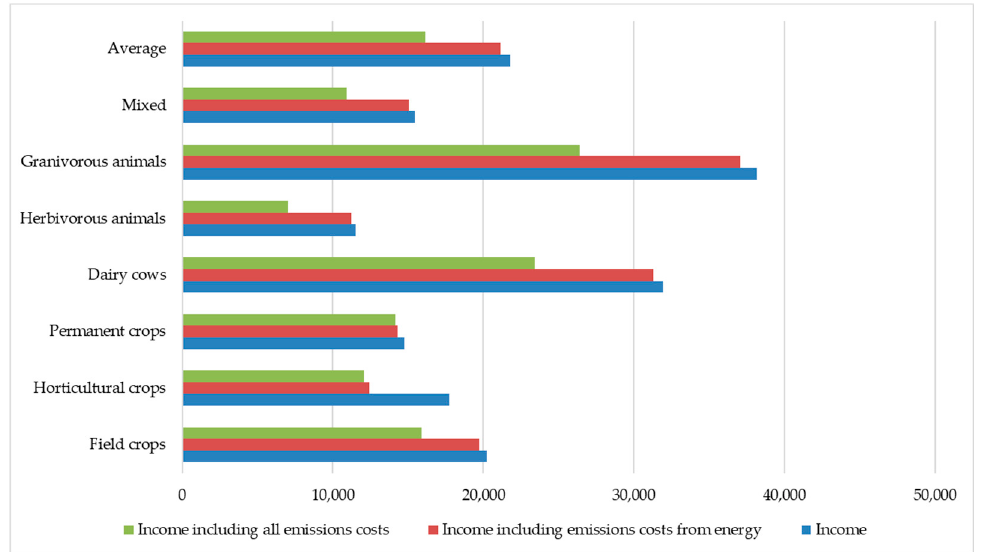
Figure 8. Farm income before and after taking into account GHG emission costs in EUR. Source: own study.